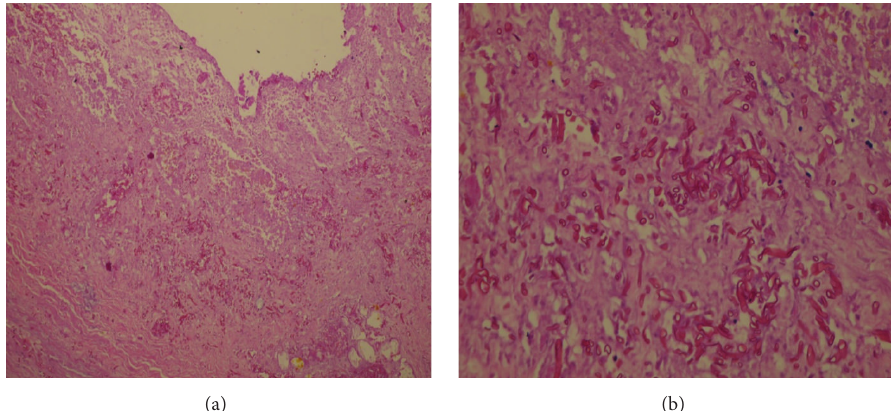
Figure 3: (a) H & E 100x showing necrotic appendicular wall with fungal colonies. (b) H & E 400x showing fungal colonies in the appendix.